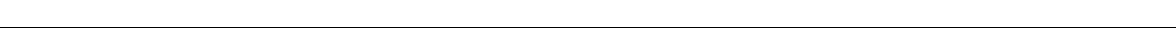
Fig. 5 Alt-NHEJ partially contributes to gross genomic instability in BRCA2-depleted cells. a Schematic representation of the EGFP-based alt-NHEJ reporter assay. b BRCA2 depletion leads to an increased alt-NHEJ frequency. Wild-type or Pol θ -de fi cient U2OS alt-NHEJ-EGFP cells were transfected with